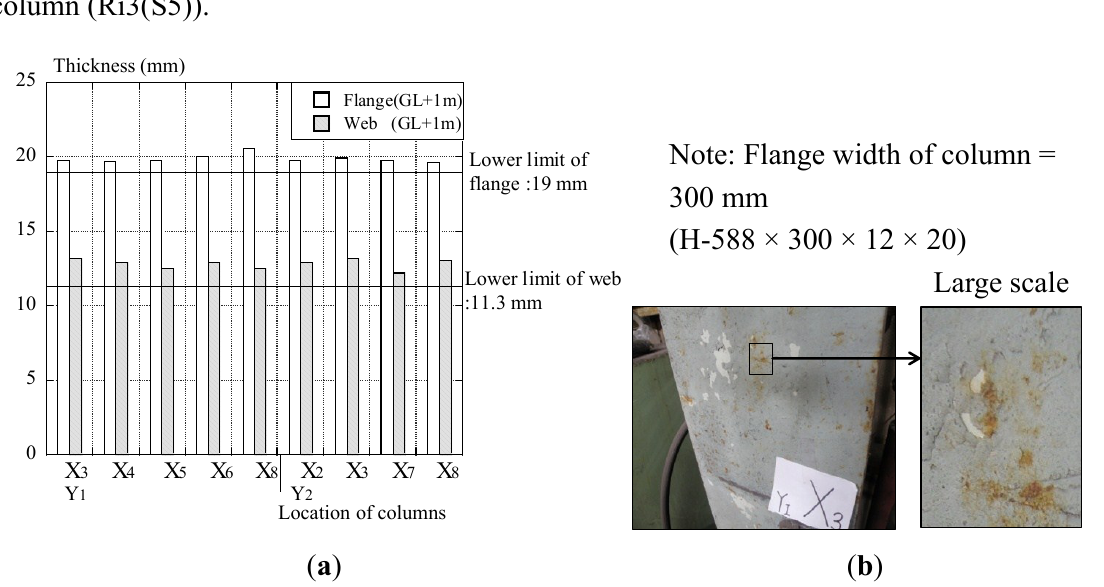
Figure 12. ( a ) Thickness of the flange and web on the column and ( b ) rusting of the Y 1 X 3 column